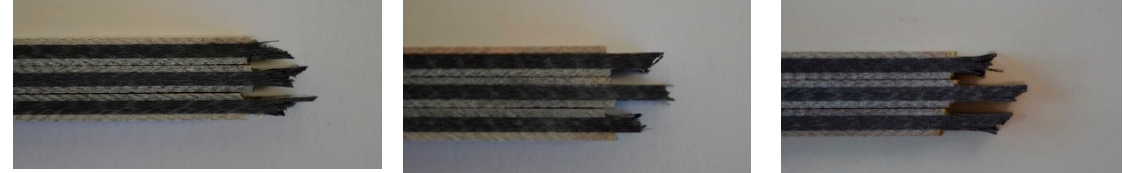
Figure 8. Fracture pattern of samples cured with TETA ( left ), IPDA ( middle ) and DDS ( right ).